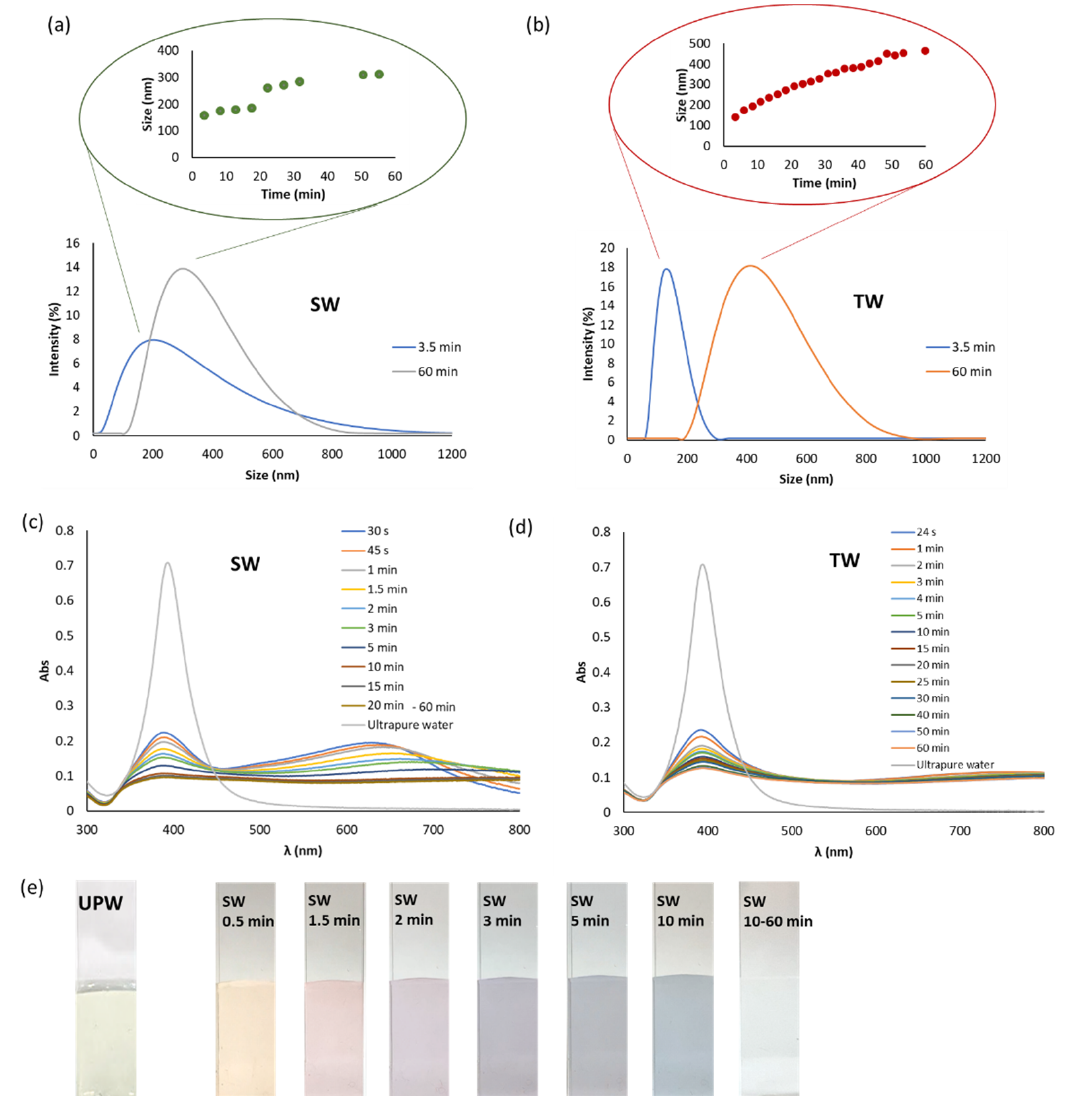
Figure 8. Static DLS and UV-spectroscopy results for batch O2 diluted 1/4 with sea (SW) and tap (TW) waters measured at several times: ( a ) DLS registers for SW at different times including an insert, which shows the changes in size of AgNPs with time ; ( b ) DLS registers for TW at different times including an insert, which shows the changes in size of AgNPs with time; ( c ) Spectra of AgNPs with SW at several times, the SPR band for the dilution with ultrapure water was also included; ( d ) Spectra of AgNPs with TW at several times, the SPR band for the dilution with ultrapure water was also included; ( e ) Colour of the suspension in SW with